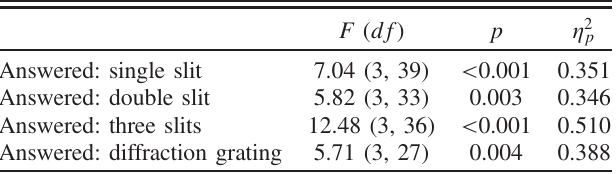
TABLE III. Results of the one-way ANOVAs conducted on dwell times on the multiple-choice patterns (single slit, double slit, three slits, and diffraction grating) for four groups of students according to their answers to the question to recognize the pattern produced by the interference of red laser light from two coherent